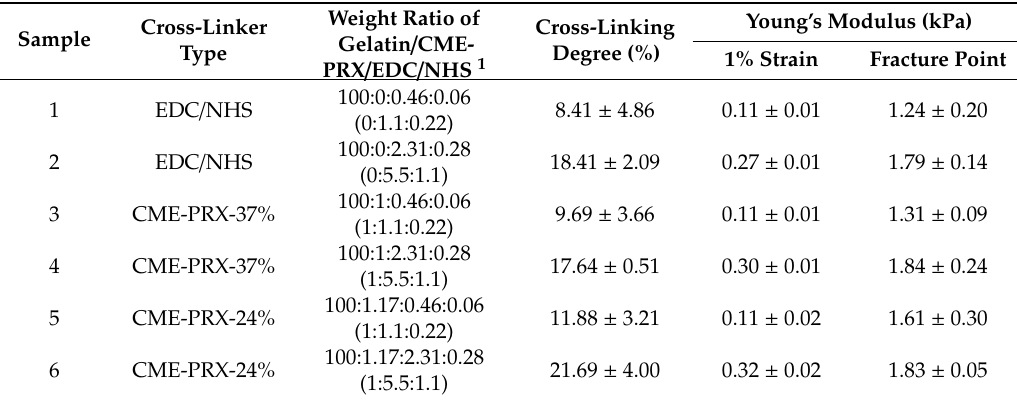
Characterization of gelatin hydrogels cross-linked with CME-PRXs and